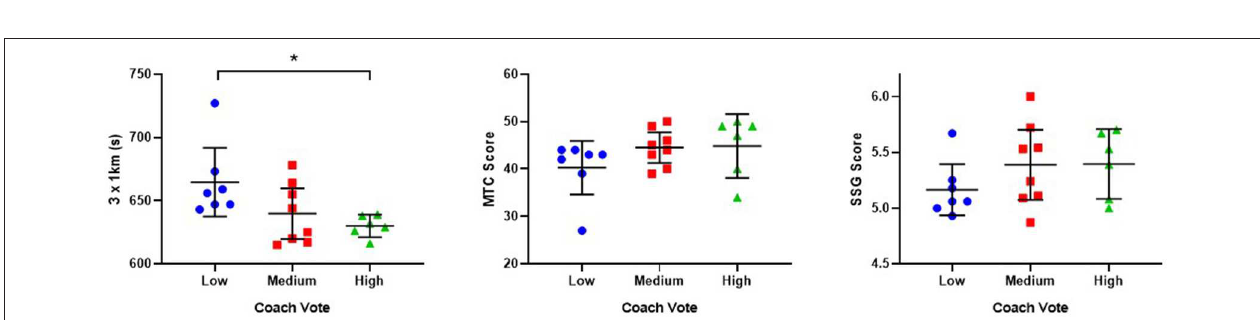
FIGURE 3 | Mean and 95% CI scores for sub-discipline performance test scores for low, medium, and high scoring groups for coach vote. *Indicates significant difference p < 0.05 between sub-groups. MTC, Mental Toughness Coach; SSG, Small sided games.